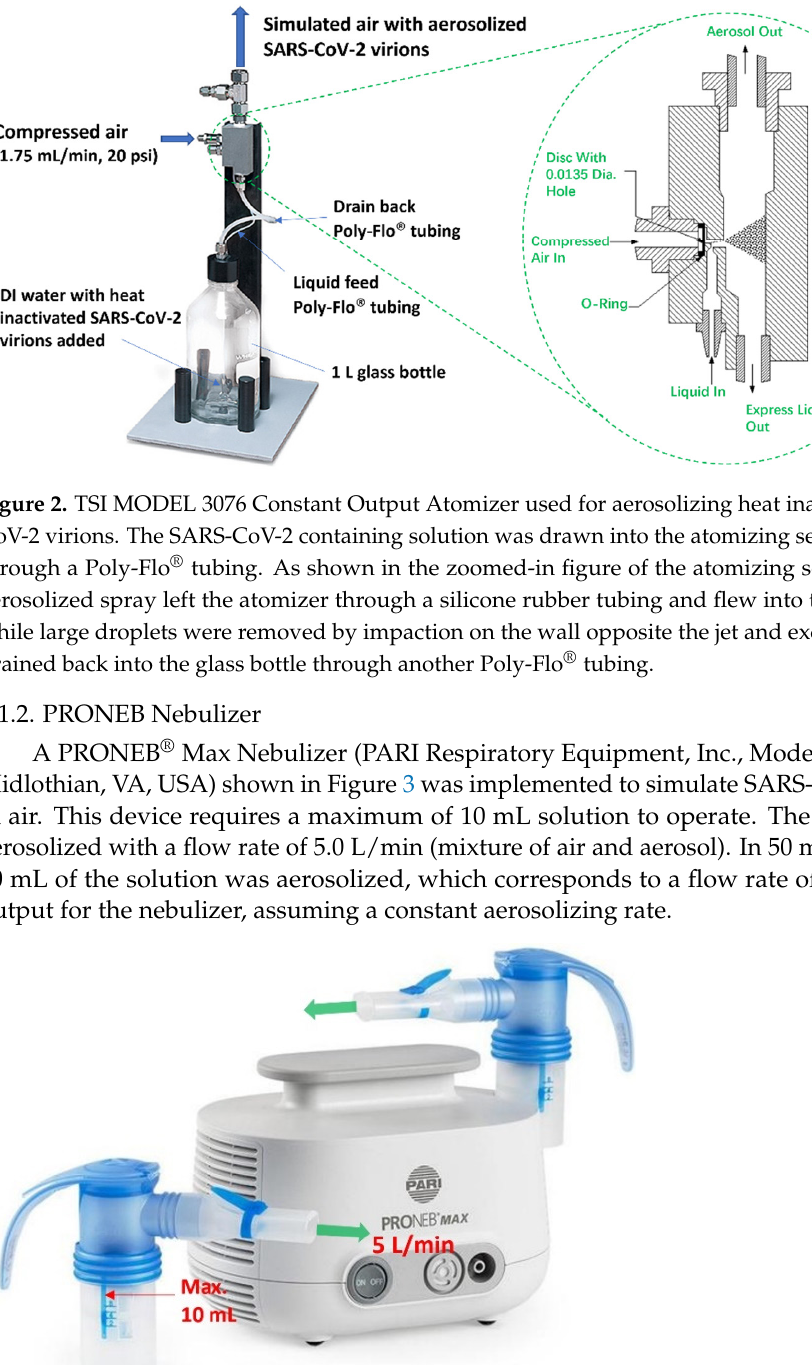
Figure 3. PRONEB nebulizer used to generate aerosols with heat inactivated SARS ‐ CoV ‐ 2 virions in the test rig.